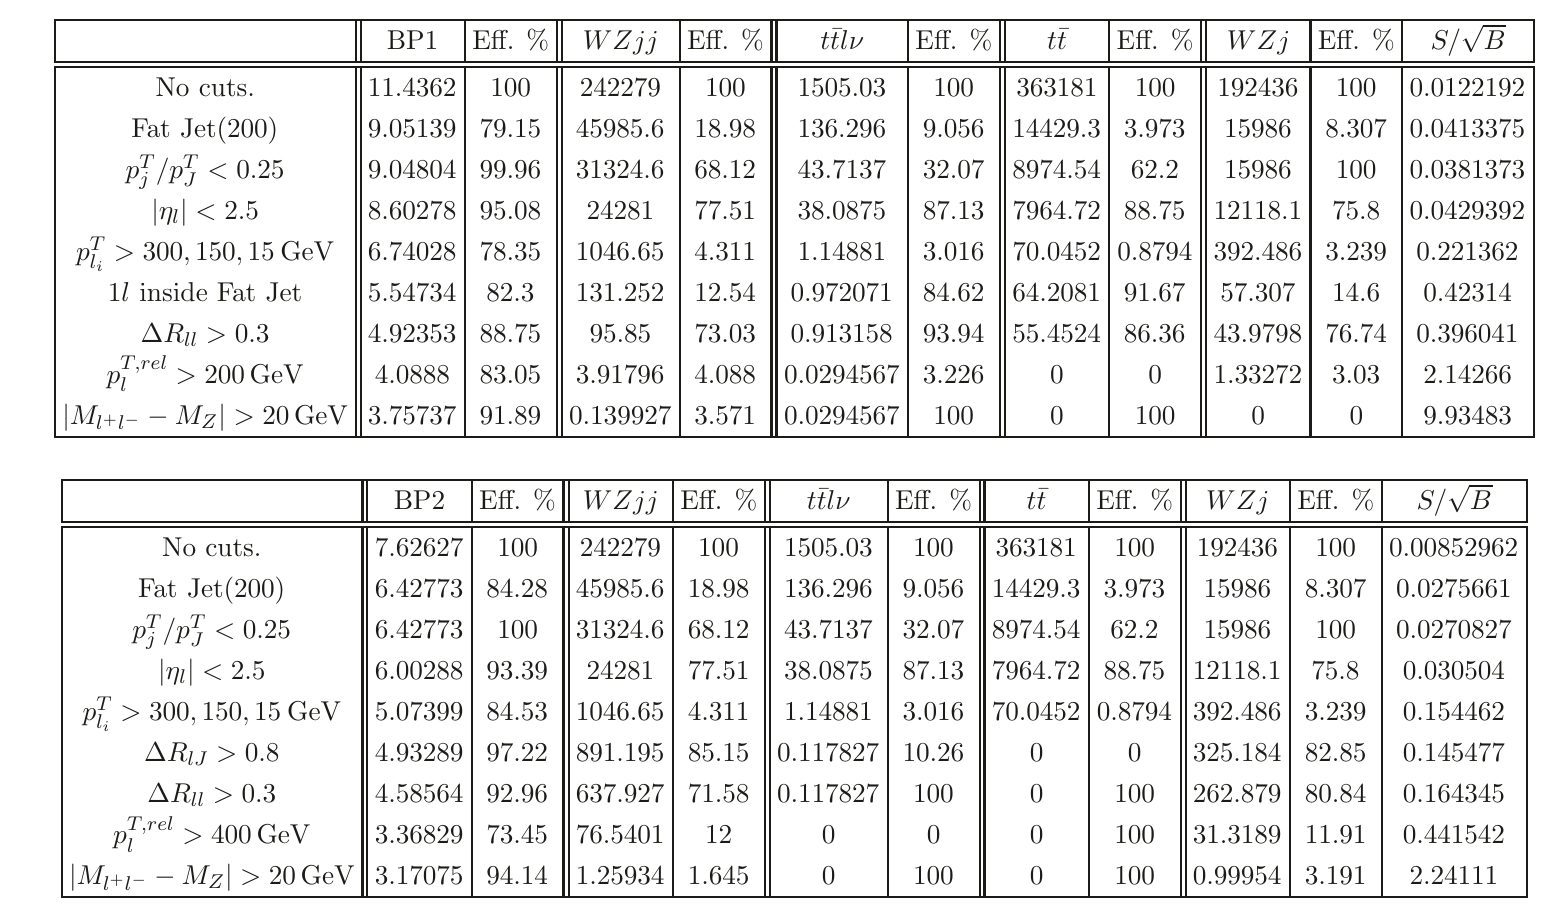
Table 8 . BP1 and BP2 benchmark points for the Z ′ -mediator case. Luminosity background as explained in the